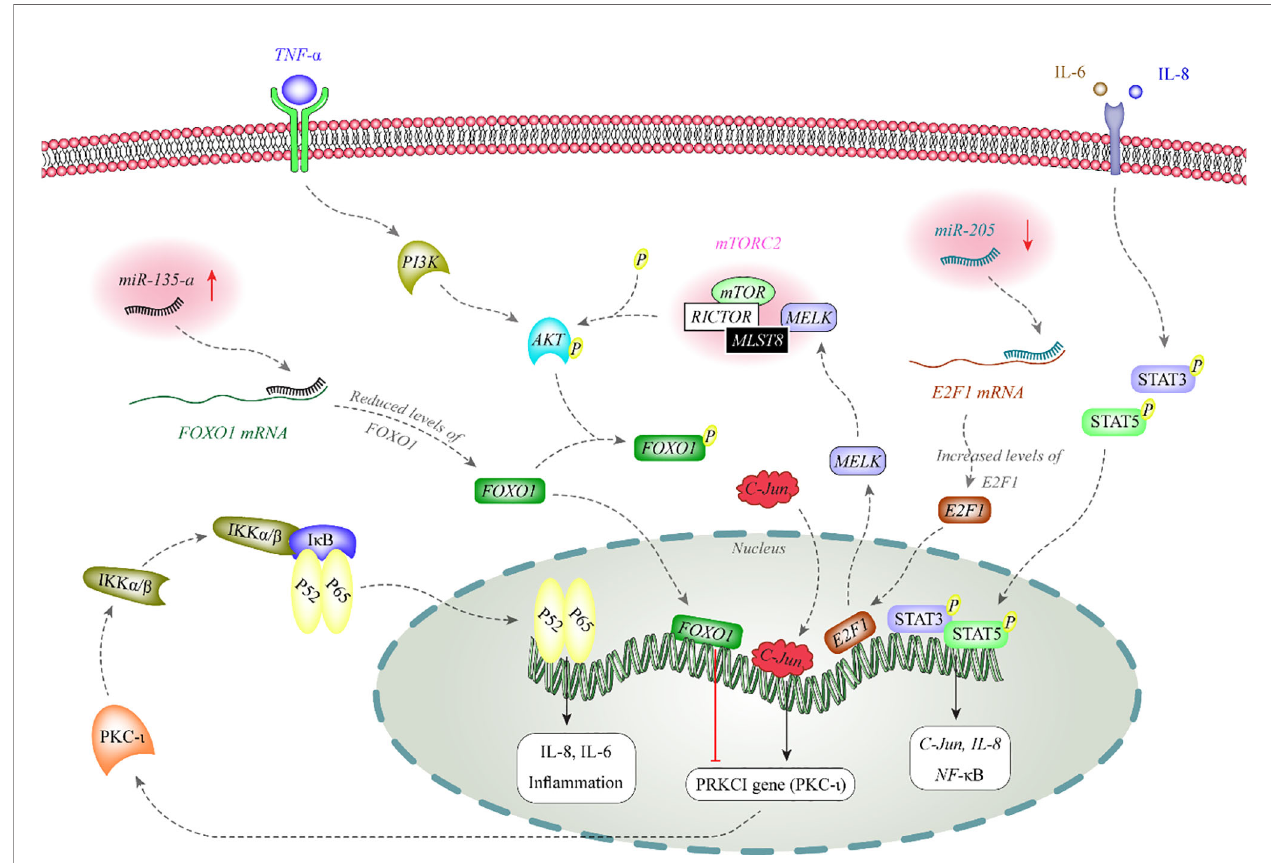
FIGURE 1 | AKT phosphorylates FOXO1 to inhibit its nuclear translocation. FOXO1 has a role in the suppression of expression of PKC-iota in the nucleus. PKC-iota is an inducer of NF- k B which enhances expression of in fl ammatory genes in the nucleus. Expression of miR-135-a is increased in melanoma. This miRNA binds with the 3 ’ UTR of FOXO1 to decrease its expression (12, 13). On the other hand, miR-205 is decreased in melanoma. This miRNA inhibits expression of E2F1 through binding with its 3 ’ UTR. E2F1 increases expression of MELK. MELK activates mTORC2 through binding with MLST8. mTORC2 has a role in phosphorylation and activation of AKT